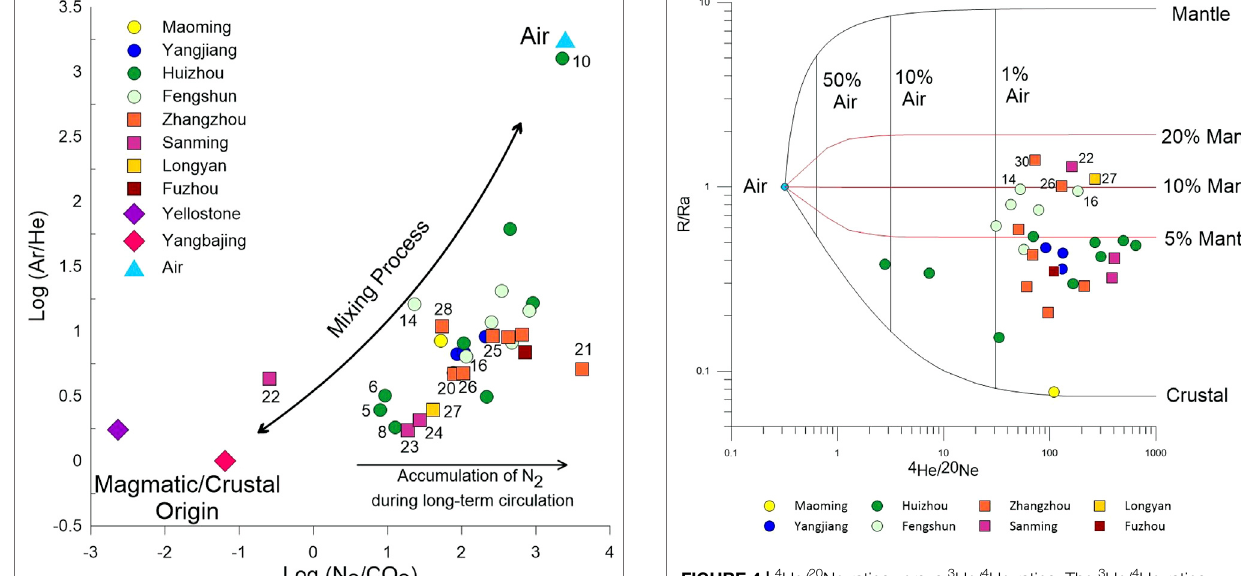
FIGURE 4 | 4 He/ 20 Ne ratios versus 3 He/ 4 He ratios. The 3 He/ 4 He ratios are expressed as R/Ra where R is the corrected measured